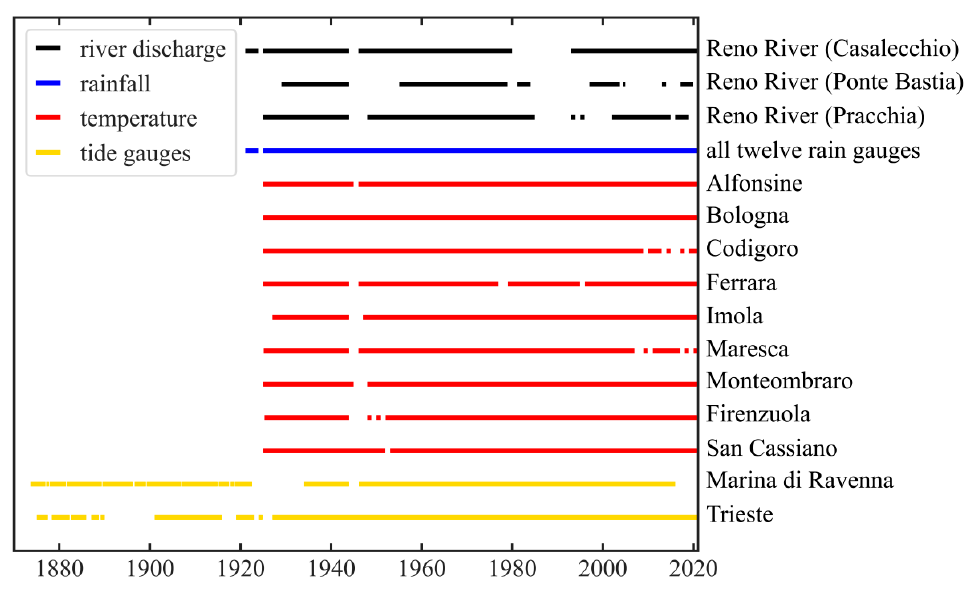
Figure 2. Duration of the considered